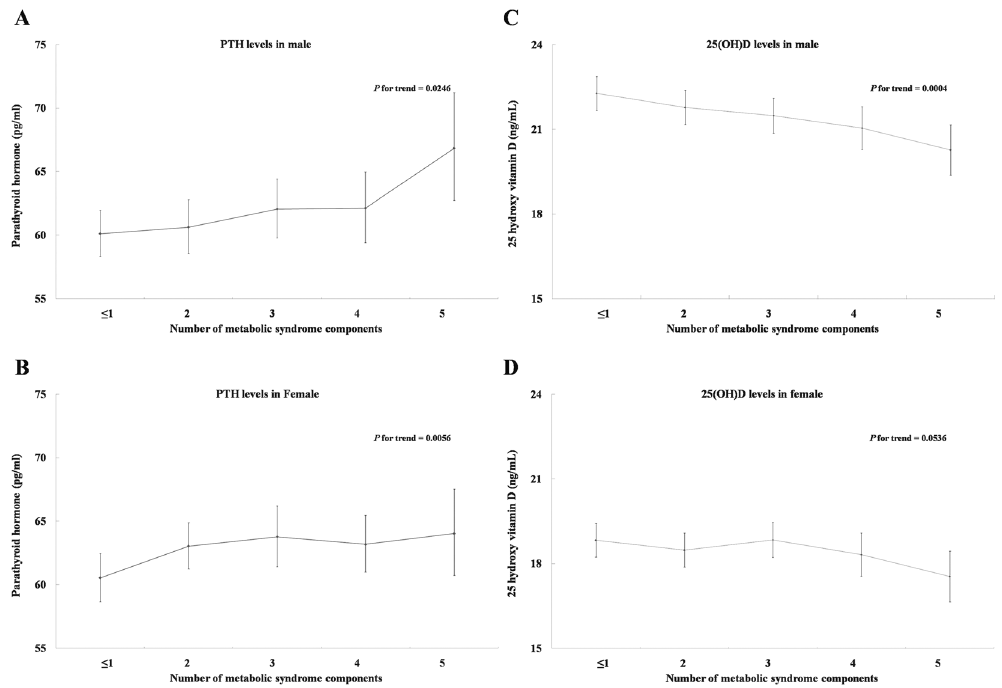
Figure 1. PTH ( A and B ) and 25(OH)D levels ( C and D ) according to the number of metabolic syndrome